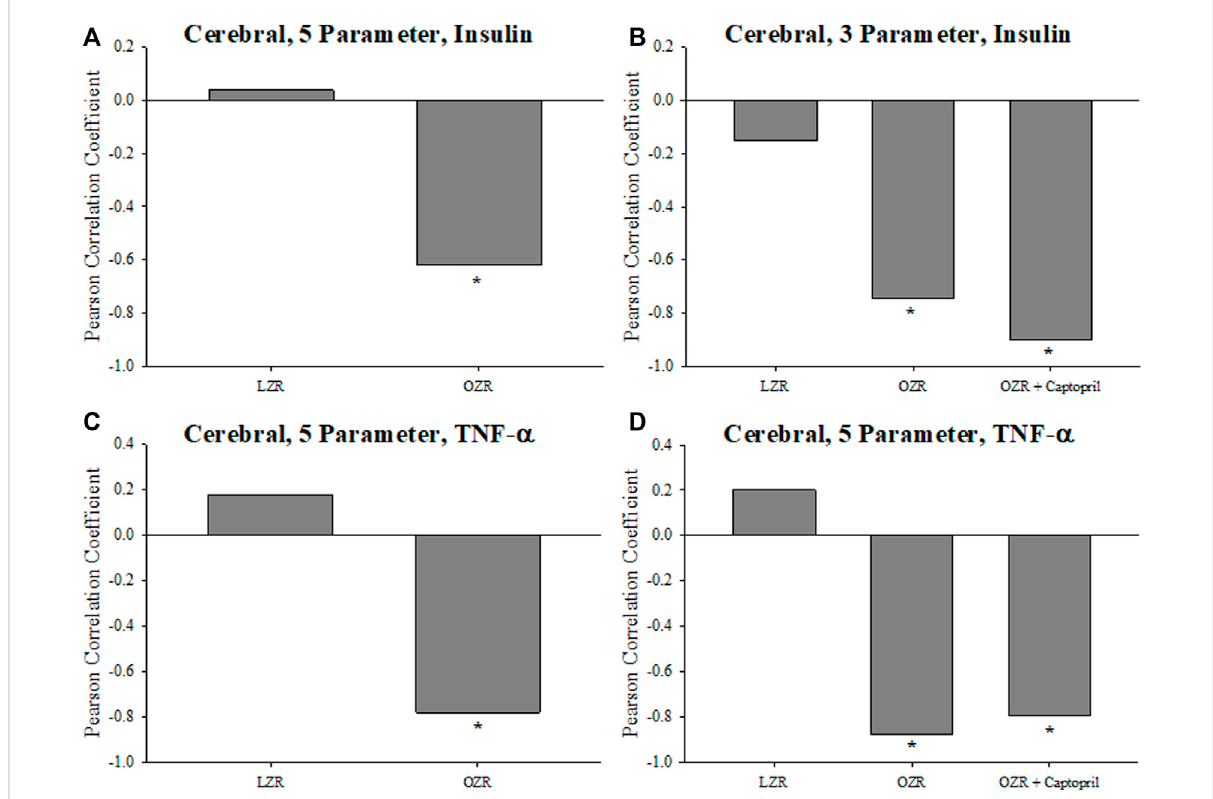
FIGURE 7 Data (mean ± SE) describing the criterion validity between plasma insulin or TNF- α and the cerebral Vascular Health Index (VHI) in the present study. The Pearson Correlation Coef fi cient between insulin and VHI in LZR and OZR are summarized in Panels (A) (5-parameter VHI) and (B) (3- parameter VHI). Panels (C) (5-parameter VHI) and (D) (3-parameter VHI) present the Pearson Correlation Coef fi cient between plasma TNF- α and cerebral VHI in LZR and OZR. Also presented are the correlations between plasma insulin or TNF- α and VHI in OZR following intervention